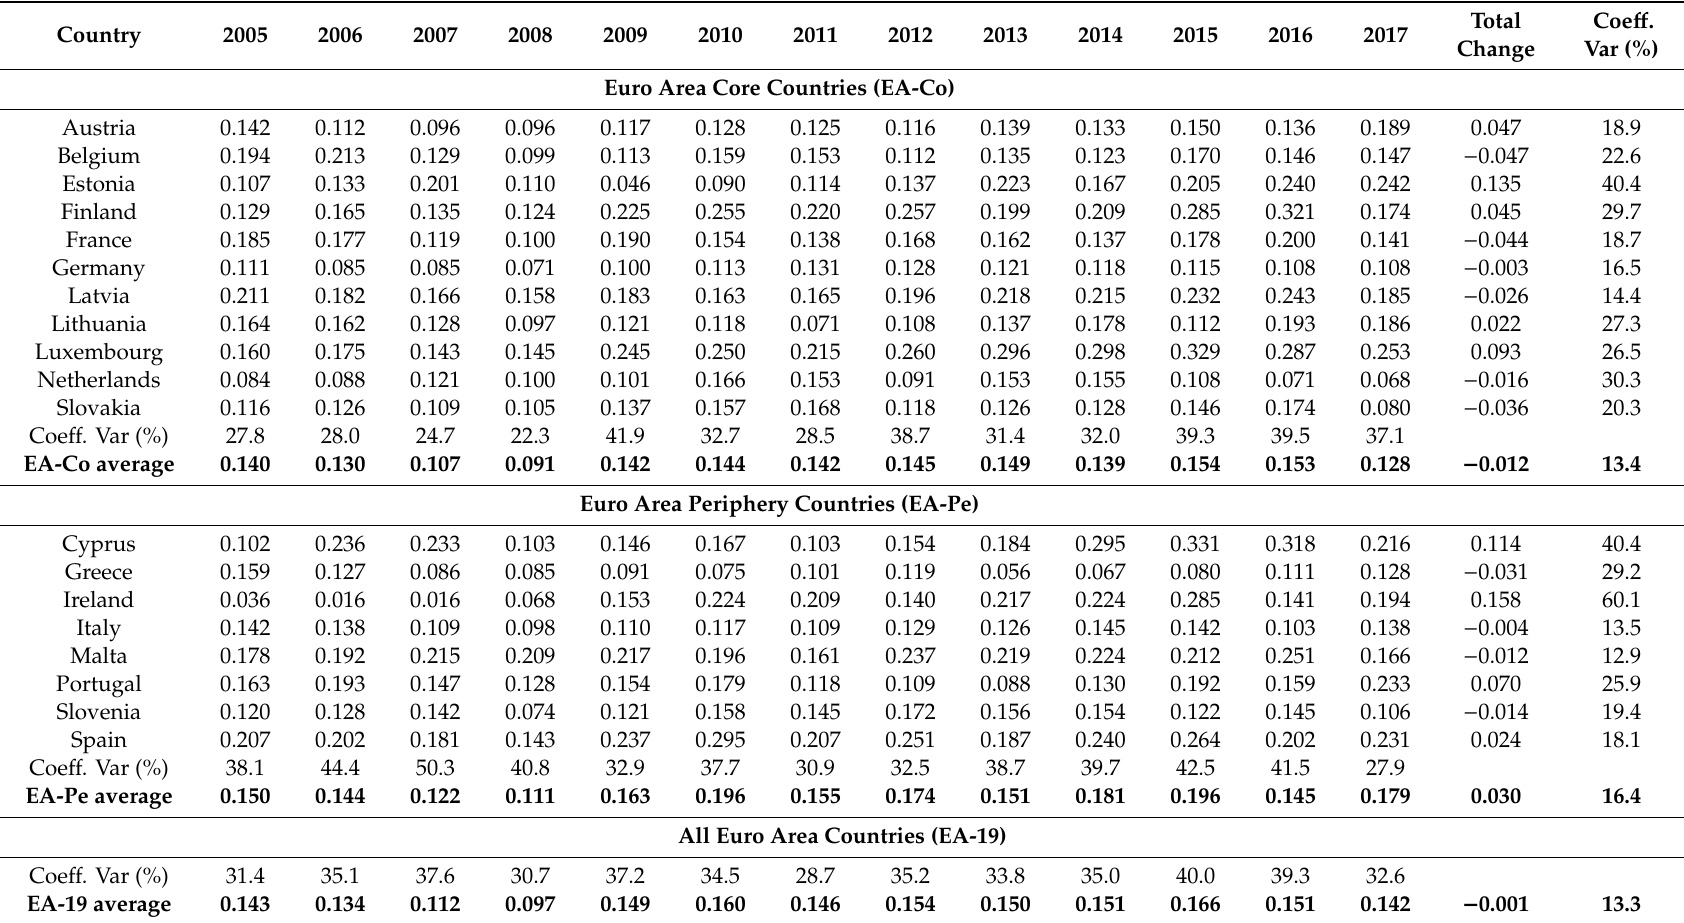
Table 1. Evolution of the Lerner index of market